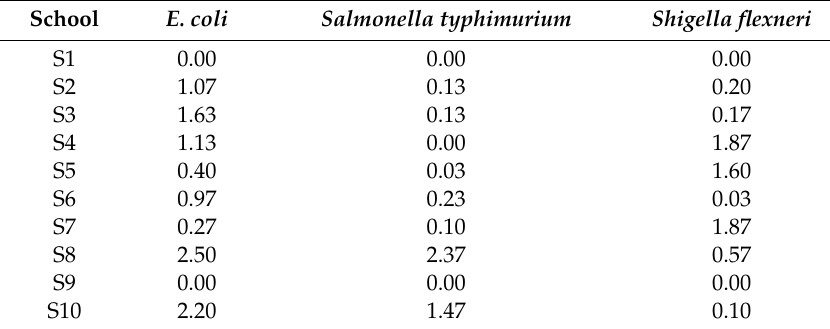
Table 3. Average ingested dose of bacteria (CFU / day).